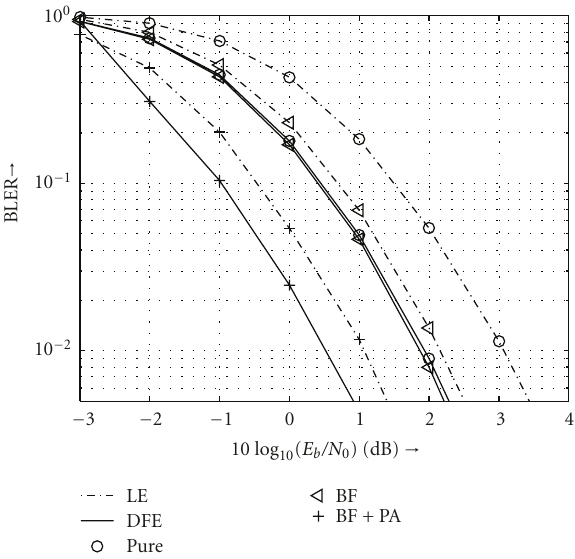
Figure 7: BLER for conventionalMMSE-LE (dash-dotted line,“o”), MMSE-LE with eigenbeamforming (dash-dotted line, “ ”), (cid:0) MMSE-LE with eigenbeamforming and MMSE power allocation (dash-dotted line, “+”), conventional DFE (solid line, “o”), DFE with eigenbeamforming (solid line, “ ”), and DFE with eigen- (cid:0) beamforming and MMSE power allocation (solid line, “+”). Pedestrian B channel